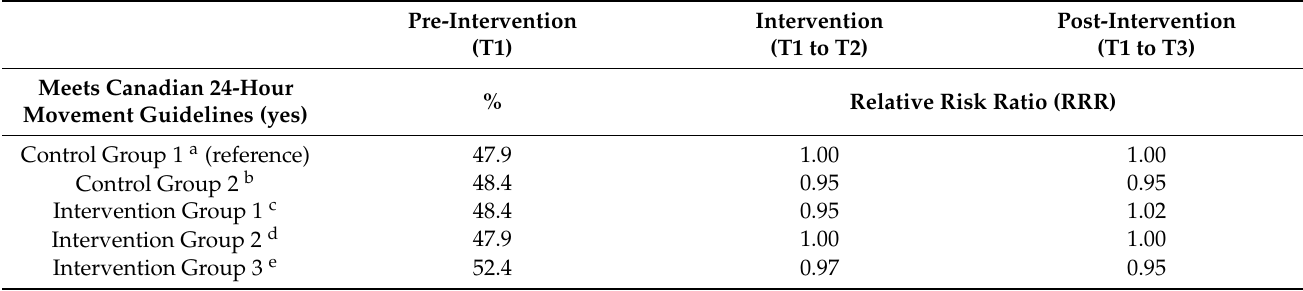
Table 2. Evaluating the impact of the Healthy Kids Community Challenge (HKCC) on meeting the Canadian 24-Hour Movement Guidelines over time in a repeat cross-sectional sample of students in the COMPASS study (2014–2015 to 2016–2017).